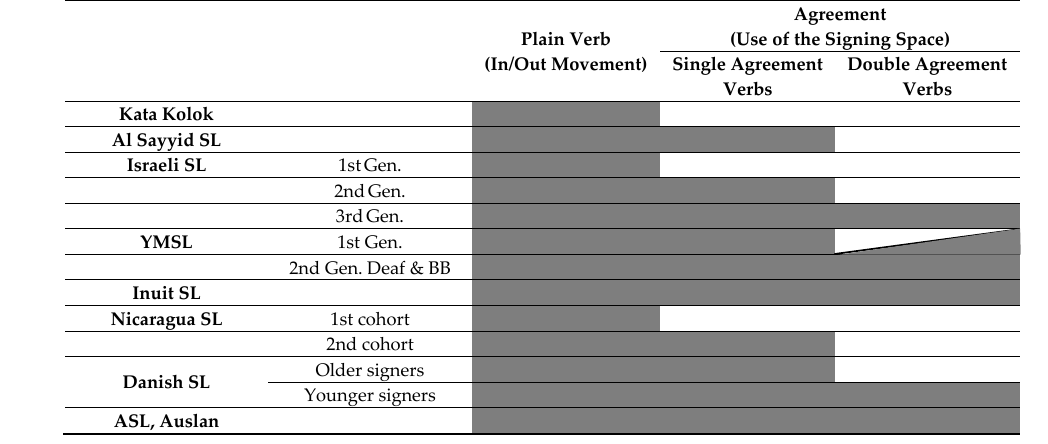
Table 5. Cross-linguistic comparison of verb agreement, based on de Vos (2012, p. 424), (Meir et al. Languages 2022 , 7 , x FOR PEER REVIEW 16 of 24 2007; Sandler et al. 2005; Aronoff et al. 2005), (Senghas 2003; Senghas et al. 2004), (Schuit 2012, 2014; Schuit et al. 2011), Engberg-Pedersen (1993), de Beuzeville et al. (2009) and Liddell (2003). Agreement (Use of the Signing Space) Plain Verb (In/Out Movement) Single Agreement Double Agreement Verbs Verbs Kata Kolok 1st